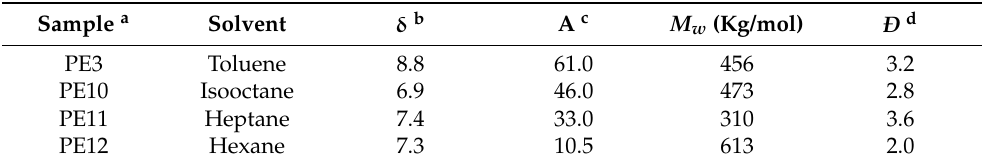
Table 4. Influence of solvents over the ethylene polymerization using CP 2 Zr(CH 3 ) 2 (Zr1) as